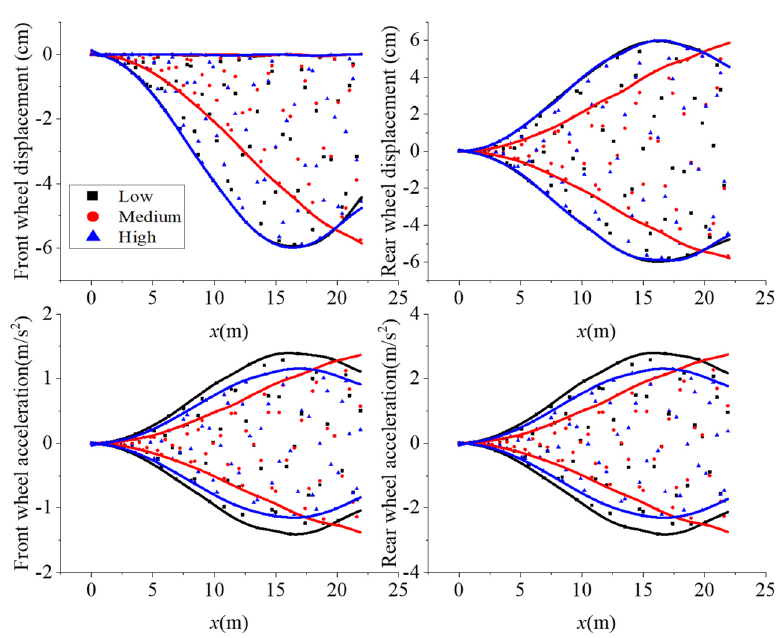
Figure 14. Net displacement and vertical acceleration 0 ≤ x ≤ ( b + c ) (The black line is the envelope of scattered points at low stiffness ratio; the red line is the envelope of scattered points at medium stiffness ratio; the blue line is the envelope of scattered points at high stiffness ratio).